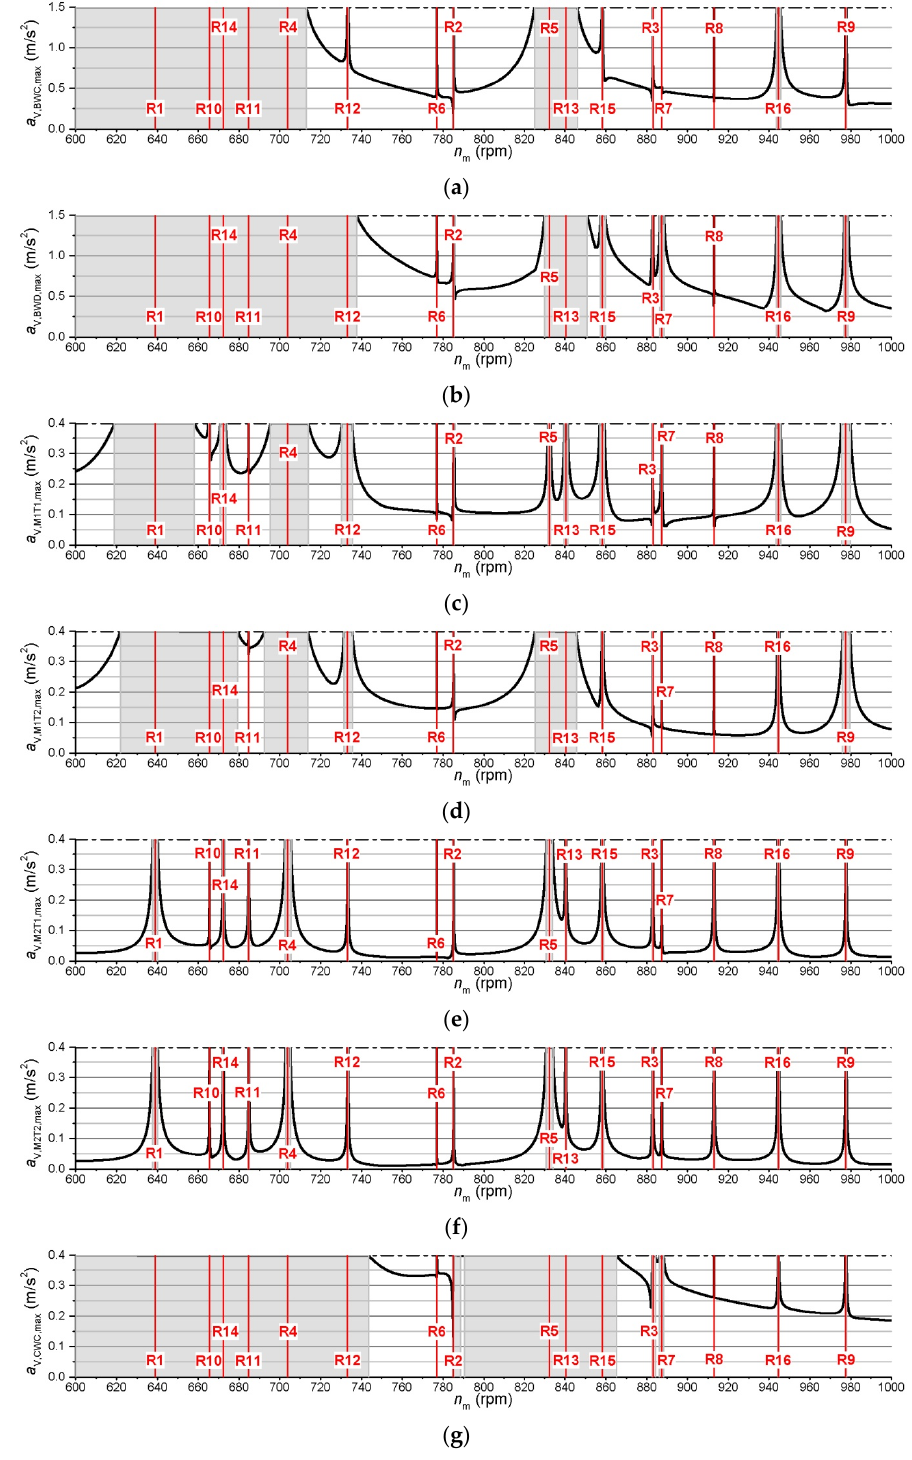
Figure 15. Total response to the excitation caused by the resistance to excavation—maximal vertical accelerations of the referent points of the slewing superstructure: ( a ) BWC; ( b ) BWD; ( c ) M1T1; ( d )